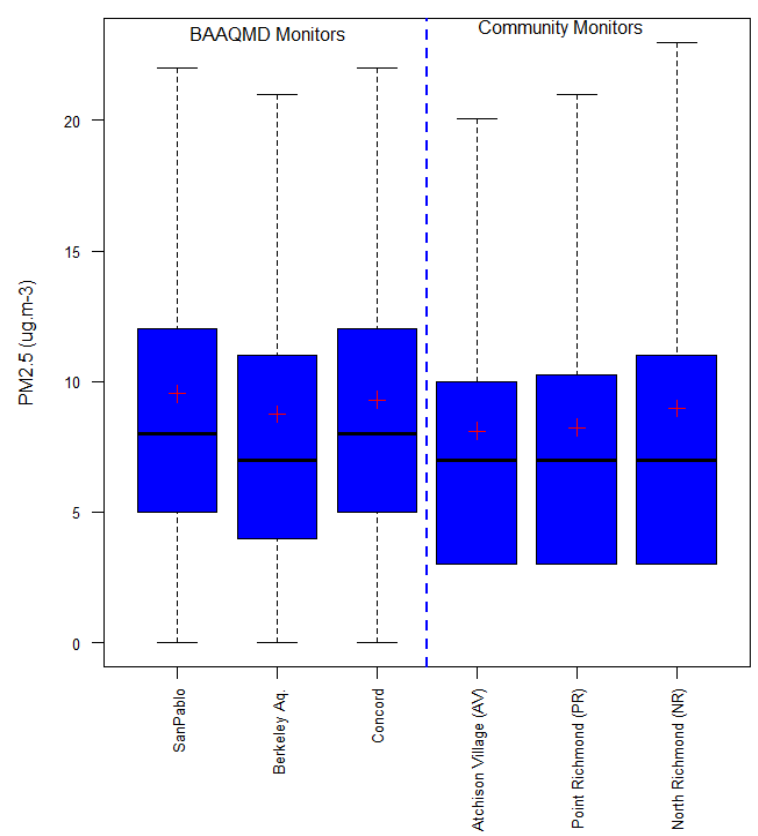
Figure 6. Distribution of 1-h PM 2.5 concentrations as measured at the three community monitors and the three BAAQMD monitoring sites in Contra Costa county during 2015–2017 (location of monitors shown in Figure S12). Bottom and top box lines indicate the 25th and 75th percentile, respectively. Line inside the boxes and red cross represent the median and average concentrations, correspondingly. Top and bottom whiskers represent the first and third quartile after subtraction/addition of 1.5 times the third-first inter-quartile range.